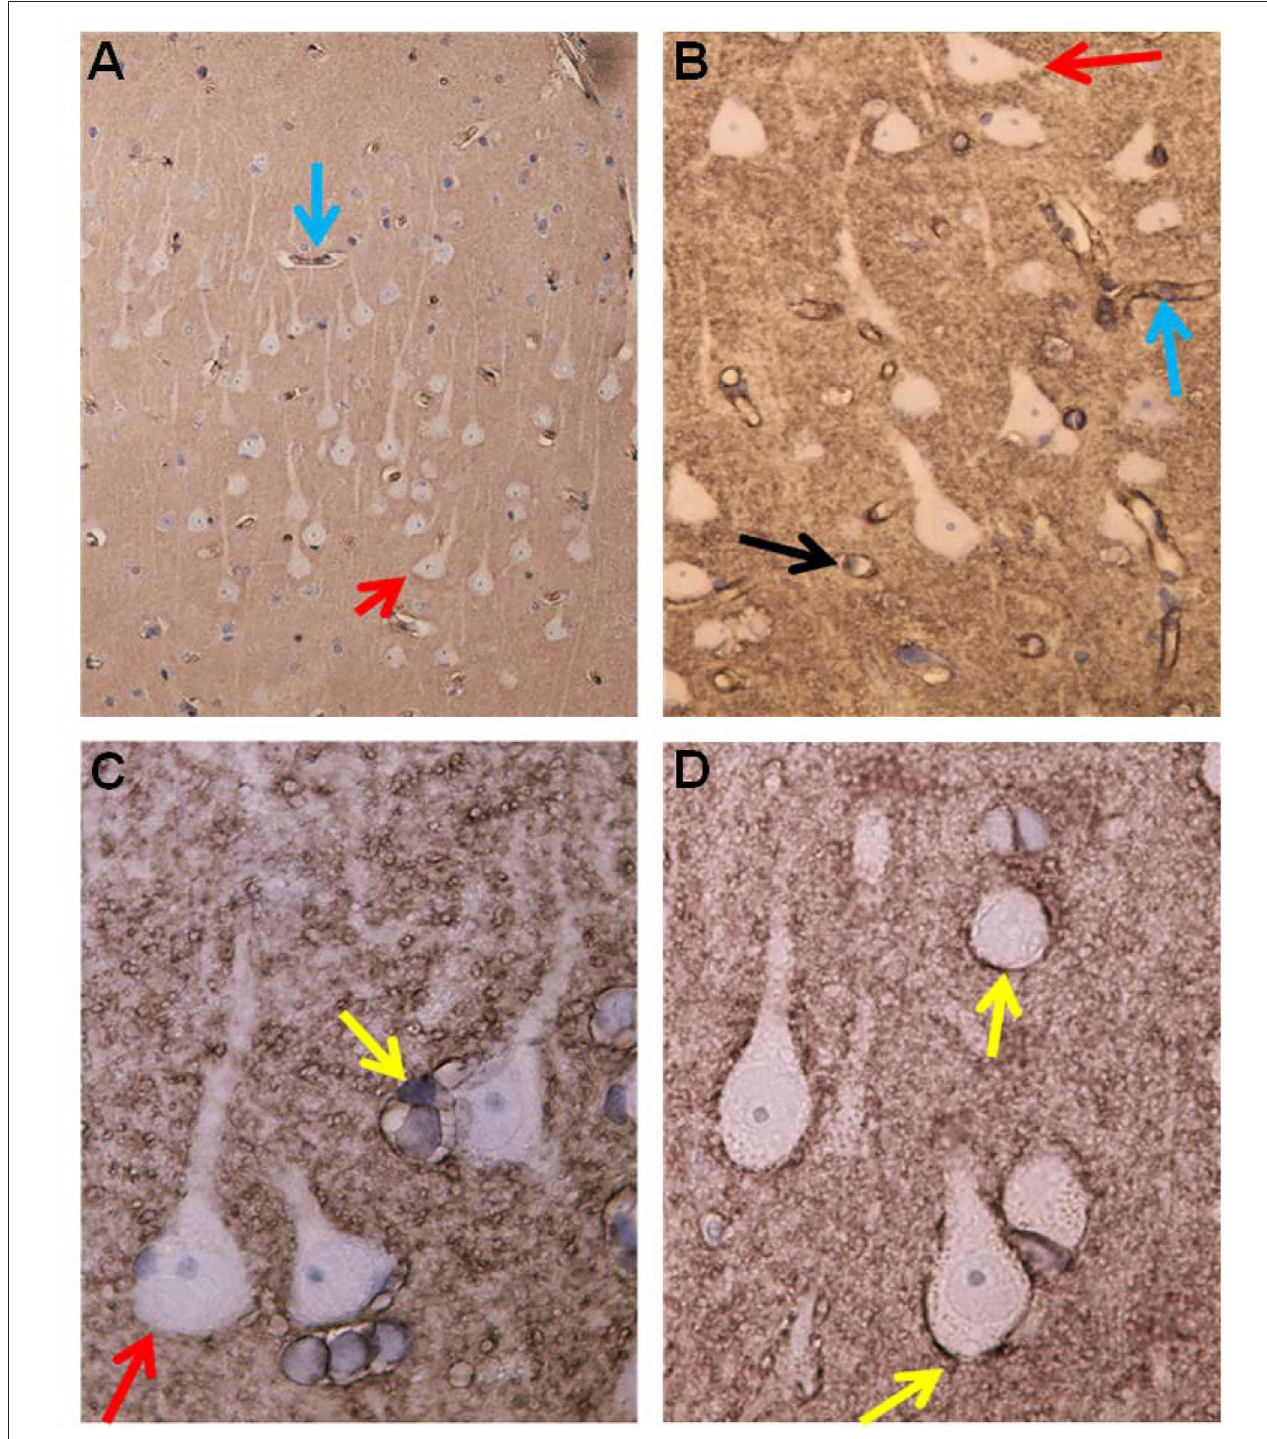
FIGURE 7 | Aquaporin 4 (AQP4)—IR in cerebral cortex of IIH subjects. (A) In cortex layers 2/3 the neurons (red arrow) lack AQP4-IR. In contrast, the cell bodies and processes of astrocytes show moderate to strong AQP4-IR. Small blood vessels are distinctly outlined due to high AQP4 IR in the astrocyte end-feet (blue arrow).